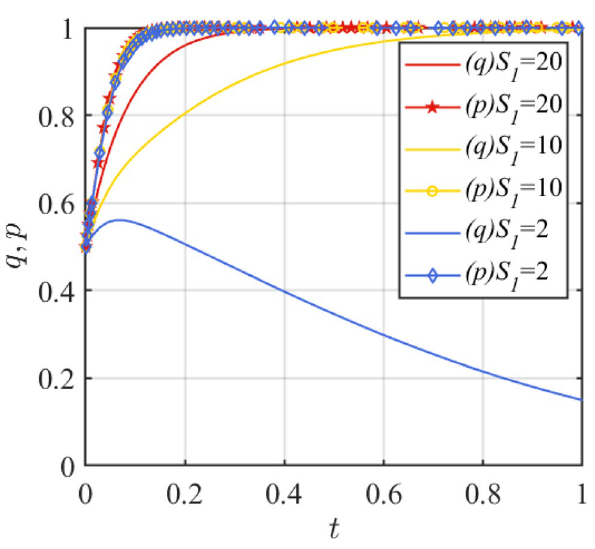
Figure 6. Effect of parameter S 1